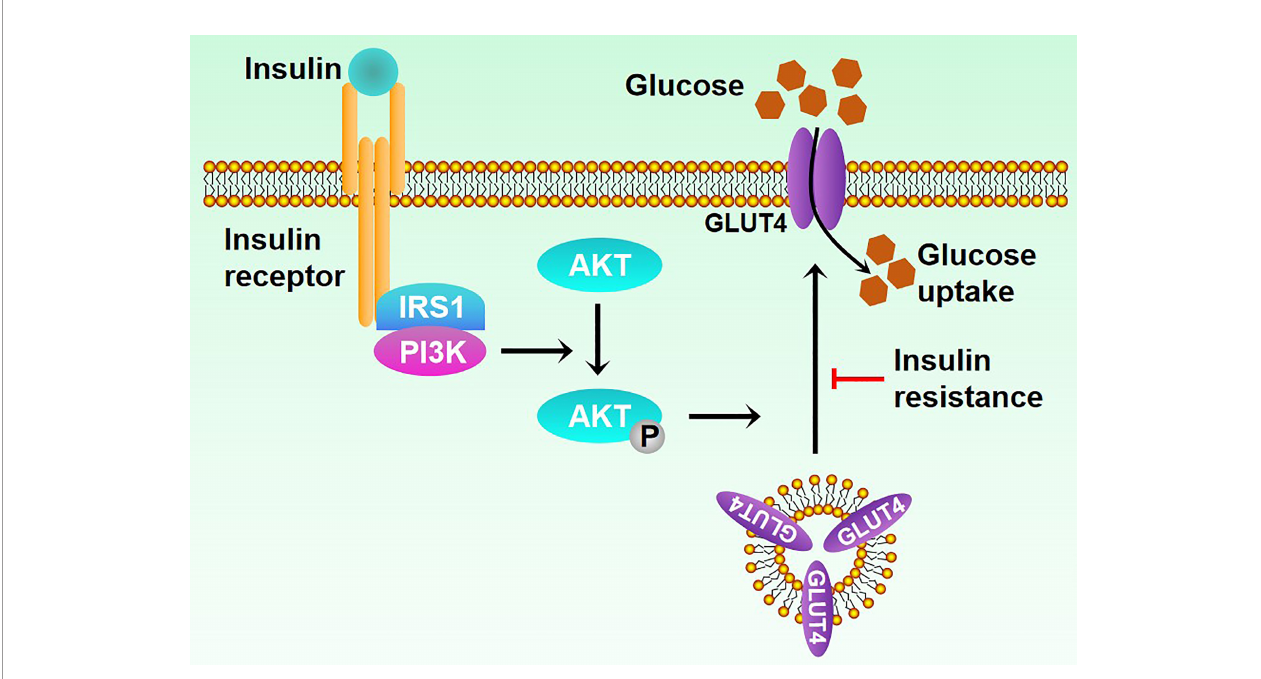
FIGURE 1 | Mechanisms of insulin